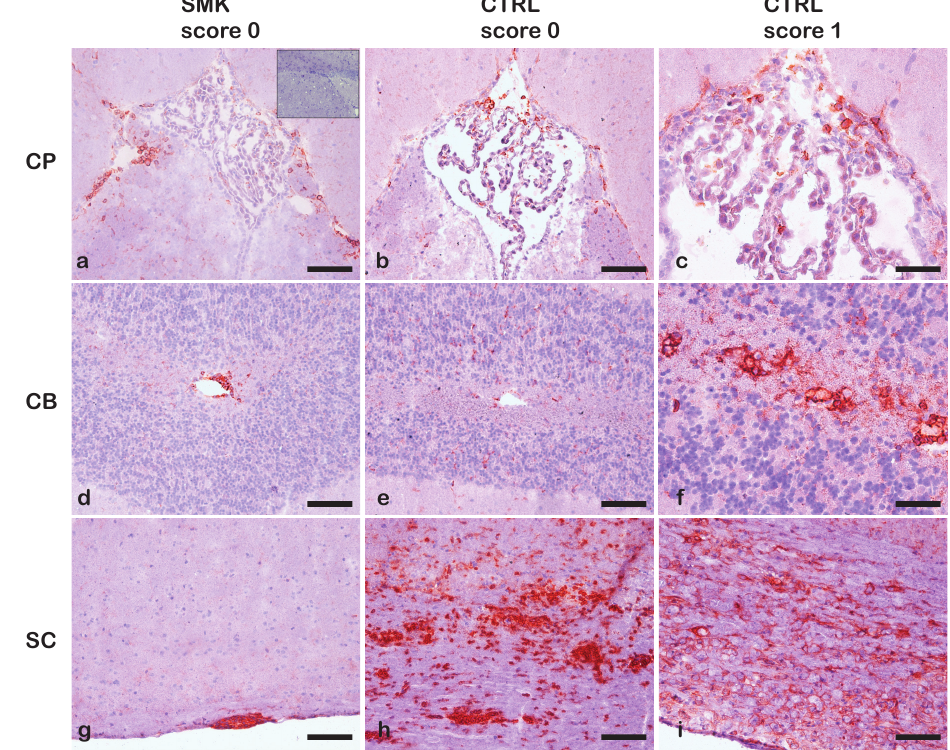
Figure 1. Distribution of CD45 + inflammatory cells in the CNS of the RR mice exposed to